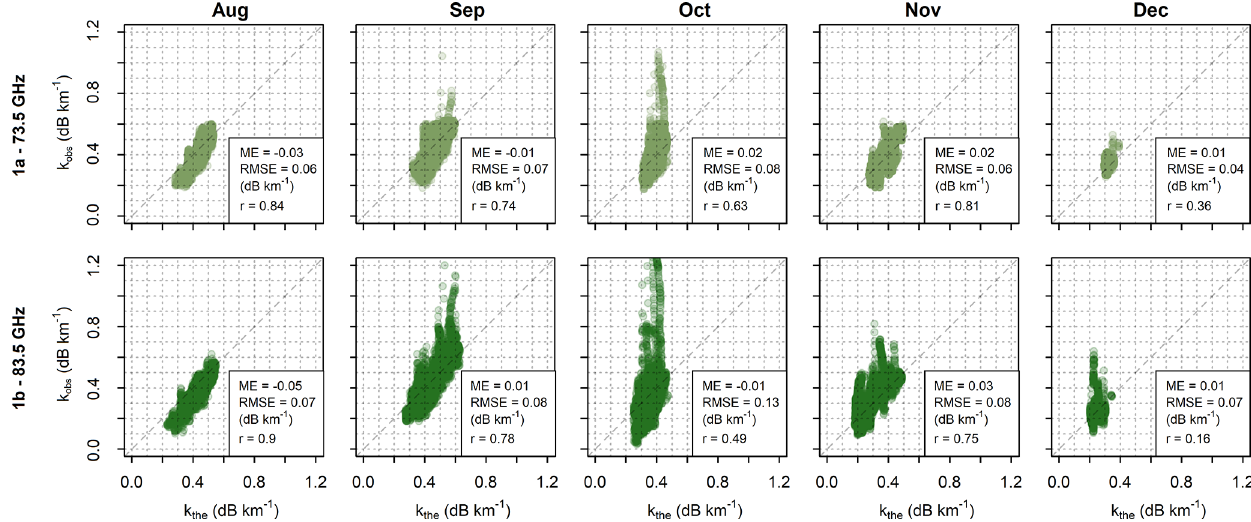
Figure 8. Comparison of theoretical ( x axis) and observed ( y axis) gas-specific attenuations at the 73.5 and 83.5GHz sublinks of CML 1 for 5min data. Data are shown separately for each month.